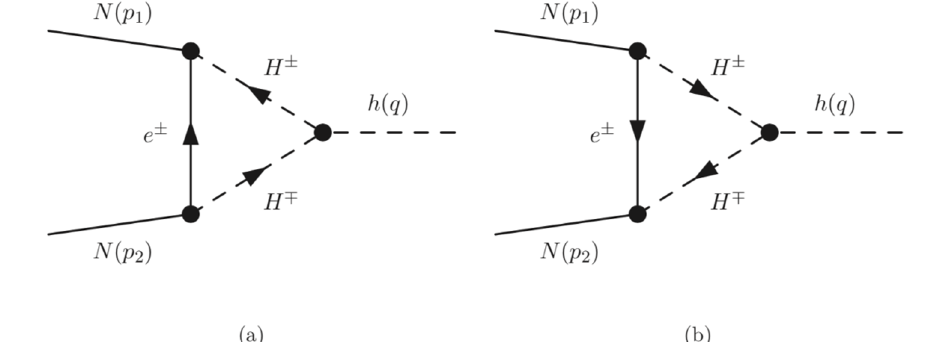
Figure 8 . One-loop Feynman diagram for the H ( q ) → N ( p 1 ) N ( p 2 ) process which gives rise to the effective ˜ y HNN